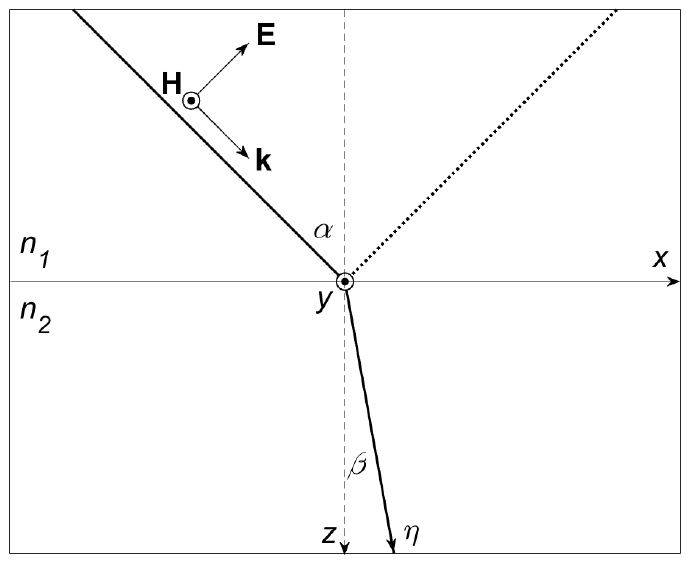
Figure 2. P -polarized wave. The designations correspond to Figure